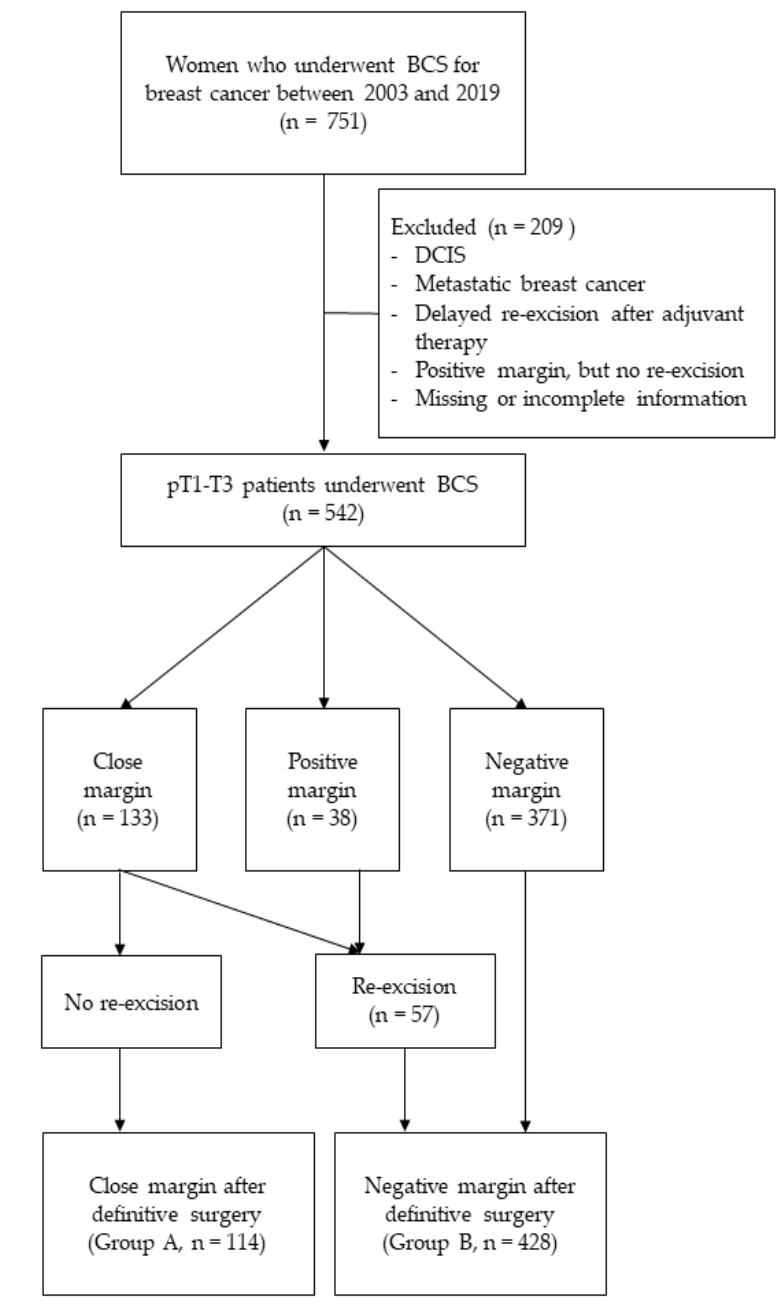
Figure 1. Patient selection